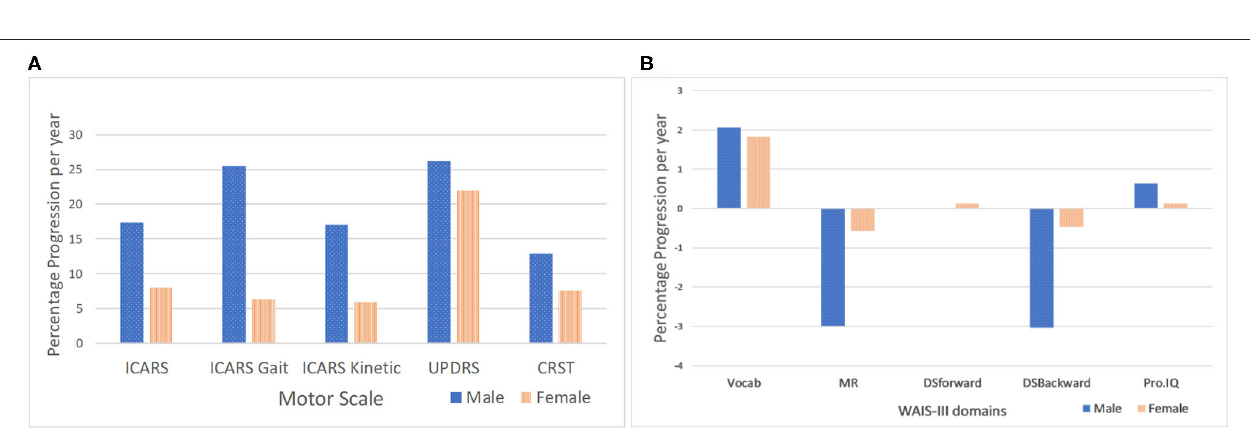
FIGURE 2 | Profile plot of mean baseline and follow-up of SCL-90 in female carriers. (A) The p values represent significance of the rate of progression. (B) Profile plot of mean baseline and follow-up of SCL-90 in male carriers. (C) Gender differences in the rate of progression of SCL-90 GSI score and individual domains in male and female carriers. (C) None of the male-female differences is statistically significant.